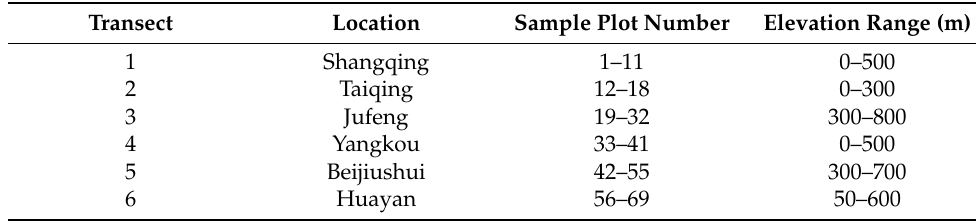
Figure 1. Locations of the 69 (20 m × 20 m) forest plots sampled along the elevational gradient of Mount Lao, northern China. The plots were established on temperate deciduous broad-leaf and temperate coniferous forests, and adult trees as well as saplings were collected. Table 1. Locations of sample plots on Mount Lao.